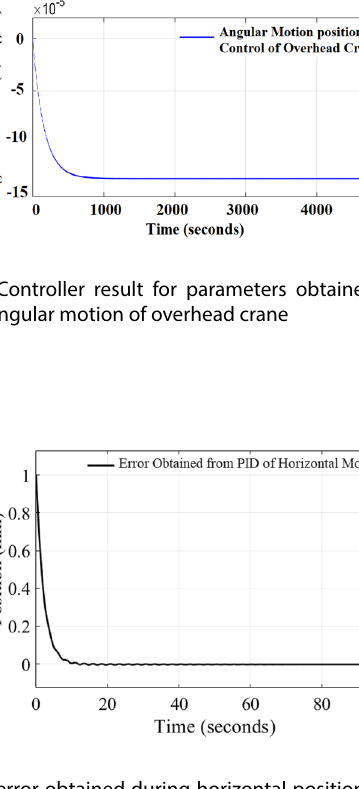
Fig. 9 The error obtained during horizontal position control of the overhead crane